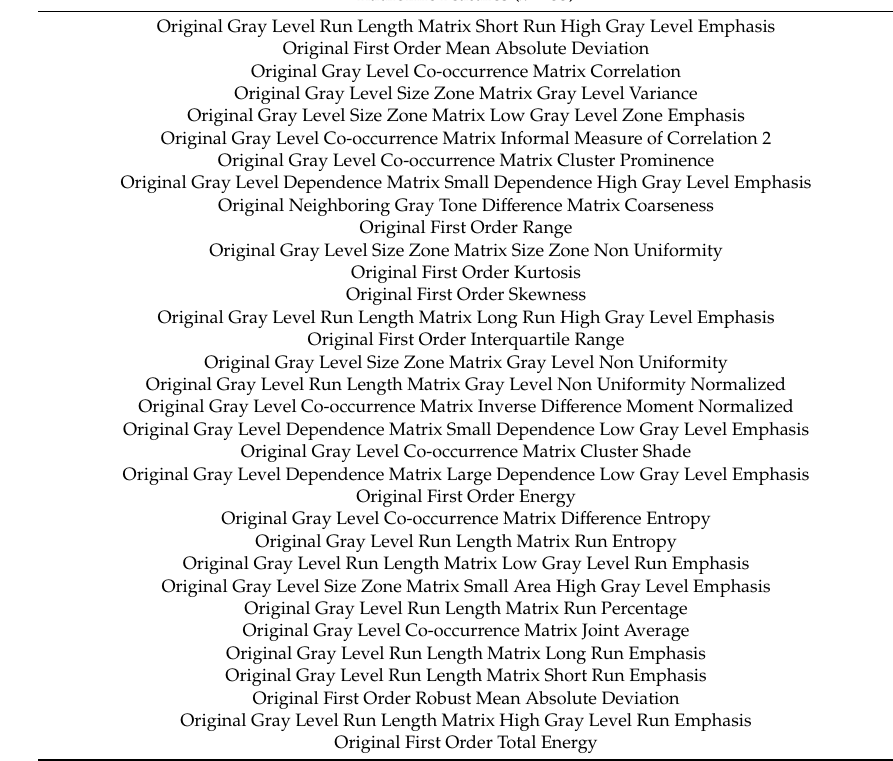
Table A5. Final Features Used by FLAIR XGBoost Model Ranked By Gain. Radiomic Features ( n = 33)